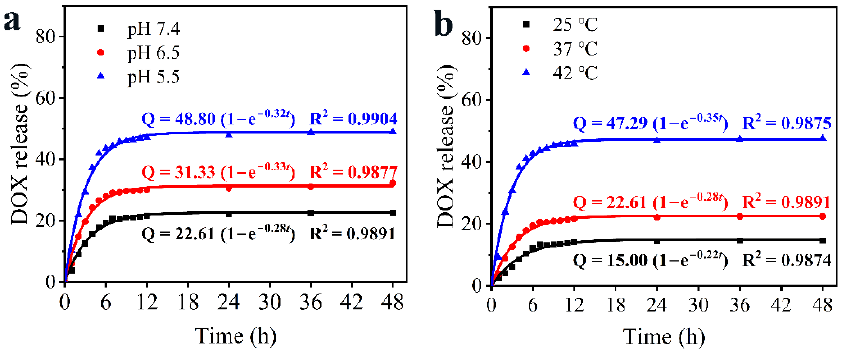
Figure 9. First-order kinetic models of DOX released from HAg 2 S@HMPDA/LA-DOX at different pH values ( a ) and temperatures ( b ).